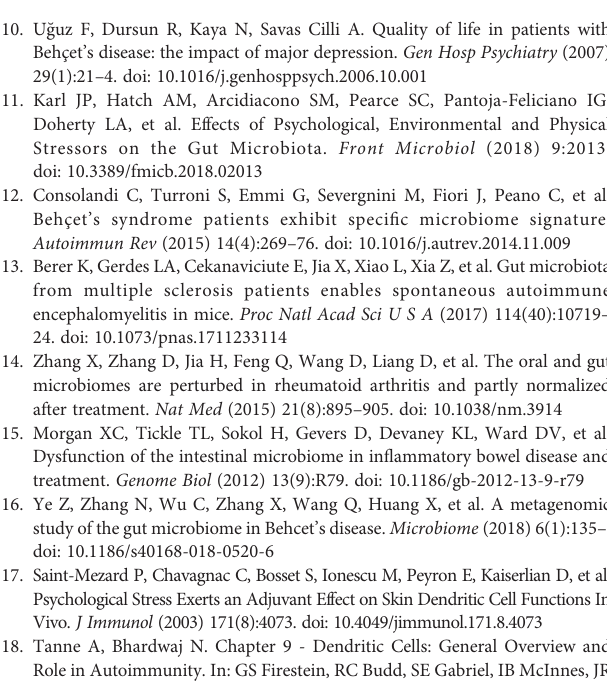
Supplementary Figure 1 | Frequencies of DC co-stimulatory molecules CD83, CD80, and CD86 in peripheral blood leukocytes (PBLs) of normal mice were elevated after noise stress induction. Isolated PBLs were analyzed by fl ow cytometric after surface staining (A – D) . For statistical analysis, one-way analysis of variance (ANOVA) was performed using GraphPad. Experiments were conducted independently at least three times.